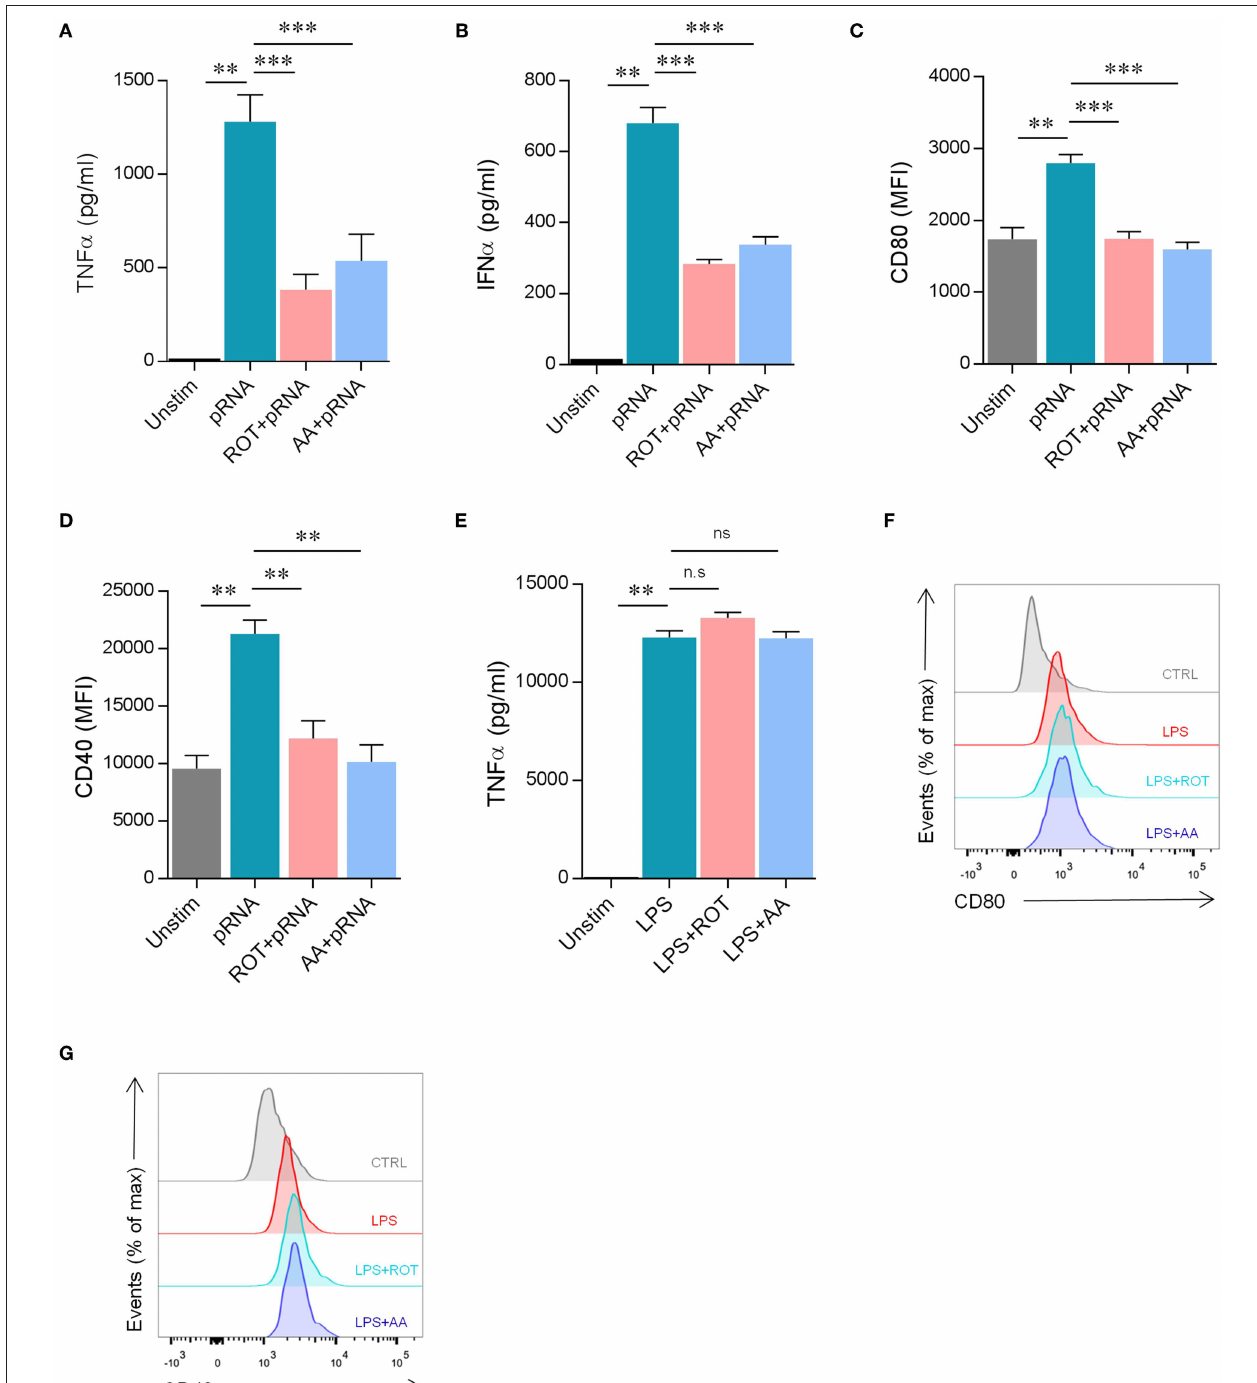
FIGURE 2 | pRNA stimulation-induced OXPHOS is required for DC maturation. (A) TNF α levels on protein level were measured in the supernatant of the DCs stimulated with pRNA for 12h in the presence or absence of 10nM rotenone or 10nM antimycin A. Data represents mean ± SEM of three independent experiments performed in triplicate. ** p < 0.01; *** p < 0.001 (Student’s t -test). (B) IFN α levels on protein level were measured in the supernatant of the DCs stimulated for 12h with pRNA in the presence or absence of 10nM rotenone or 10nM antimycin A. Data represents mean ± SEM of three independent experiments performed in triplicate. ** p < 0.01; *** p < 0.001 (Student’s t -test). (C) Mean fluorescence intensity of CD80 in DCs stimulated for 12h with pRNA in the presence or absence of 10nM rotenone or 10nM antimycin A. Data represents mean ± SEM of three independent experiments performed in triplicate. ** p < 0.01; *** p < 0.001 (Student’s t -test). (D) Mean fluorescence intensity of CD40 in DCs stimulated for 12h with pRNA in the presence or absence of 10nM rotenone or 10nM antimycin A. Data represents